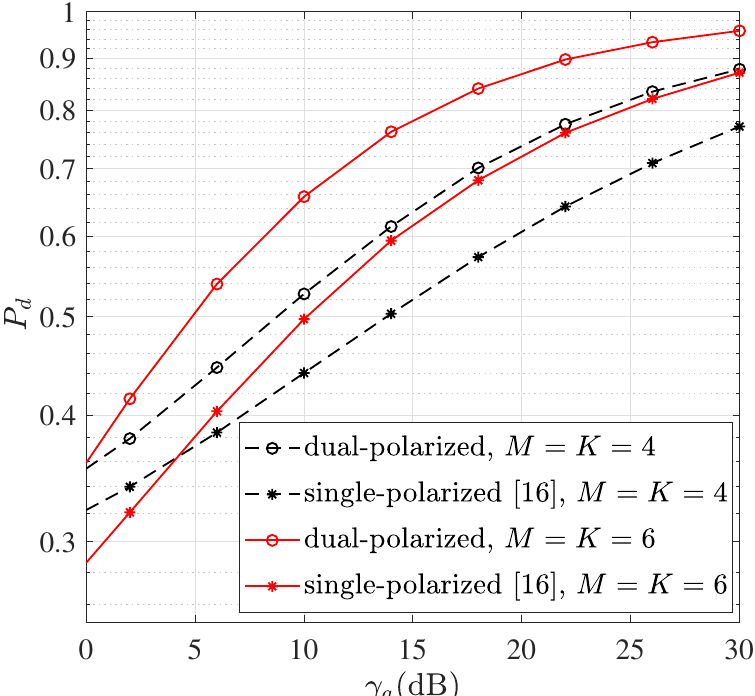
Figure 2. Detection probability of m (cid:48) , P d versus γ a , where N = 12 and I = 8.